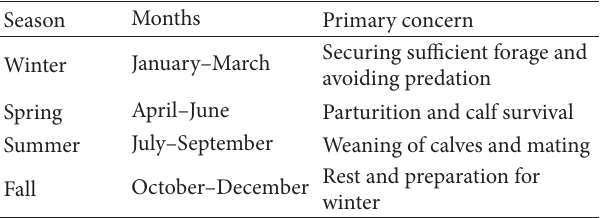
Table 1: Seasons based on elk